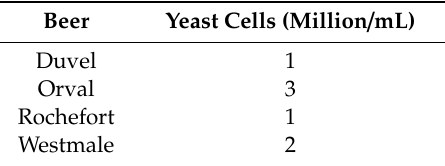
Table 1. Concentration of yeast cells for bottle conditioning in selected Belgian beers